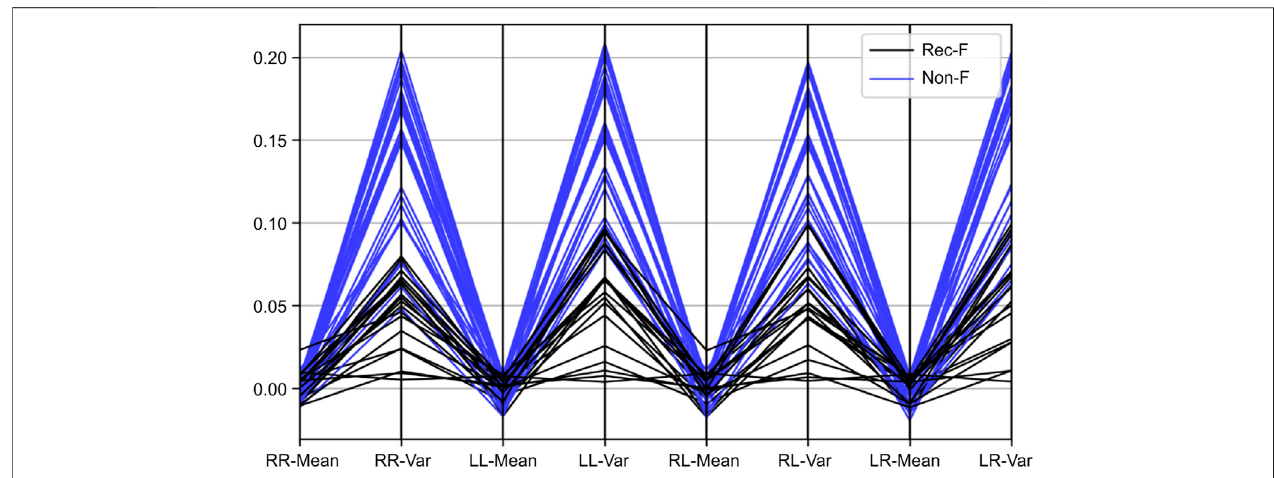
FIGURE 6 | The distribution of the values of mean (Mean) and variability (Var) of left-to-left NCC series (LL), left-to-right NCC series (LR), right-to-right NCC series (RR), and right-to-left NCC series (RL) for recurrent fallers (Rec-F) and non-fallers (Non-F) using a line chart.